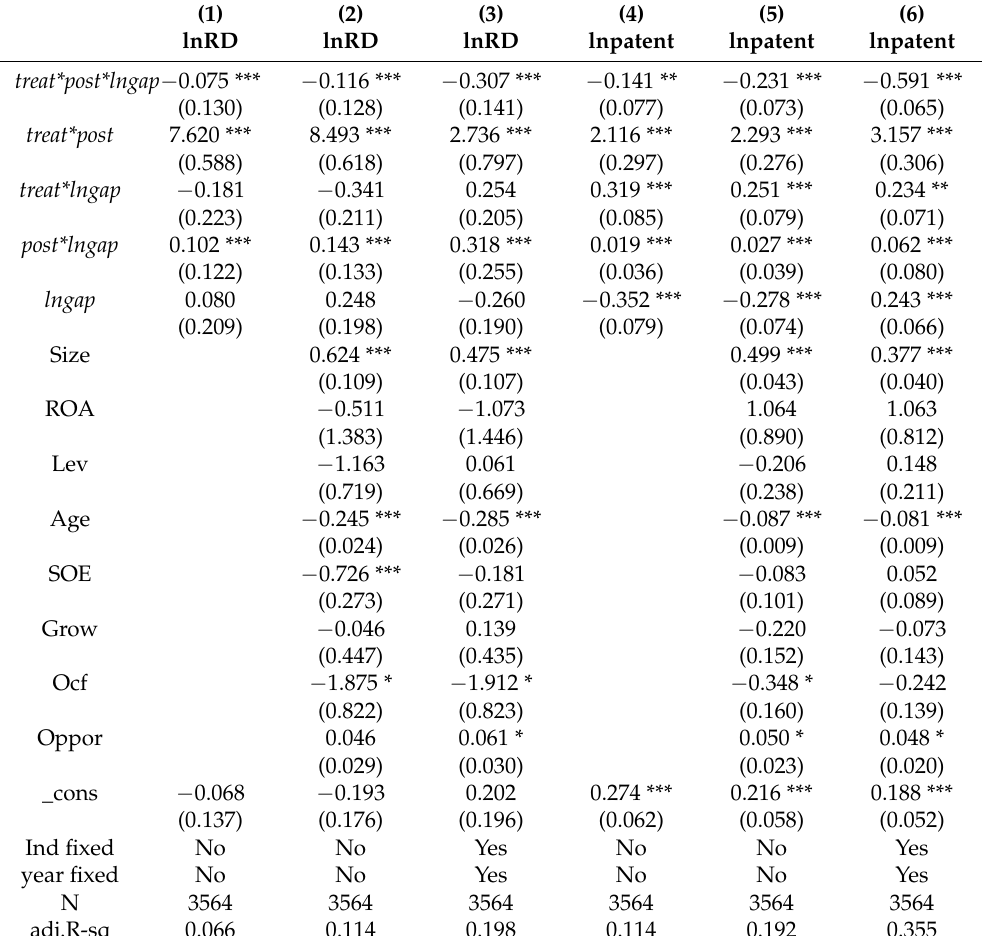
Table 5. The moderating effect of the price-MAC-gap in the carbon